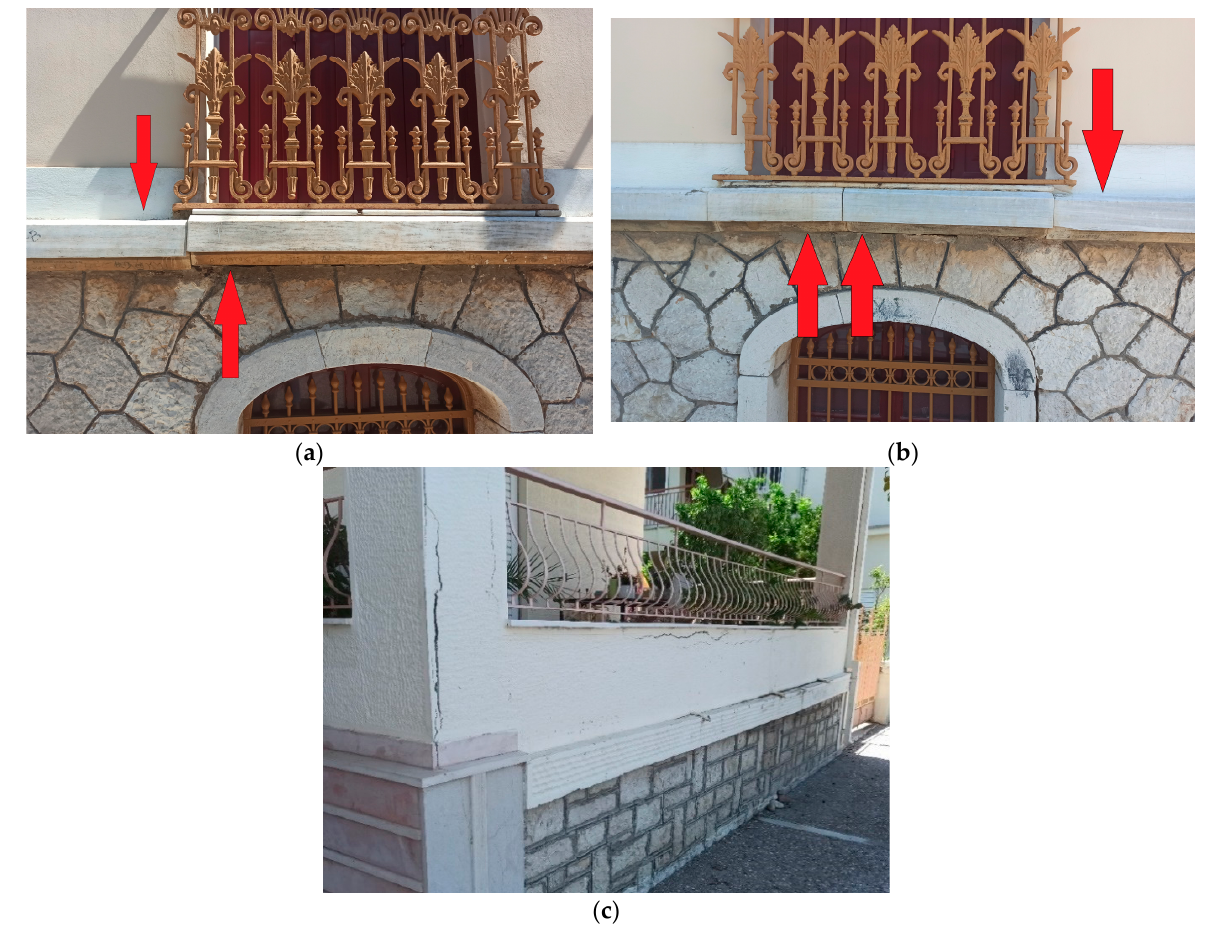
Figure 9. Damages recorded in buildings due to deferential deformations. ( a ) South side balcony damage in Building D ( b ) West side balcony damage in Building D ( c ) Balcony damage in Building E. Arrows indicate the movement trend due to subsidence.